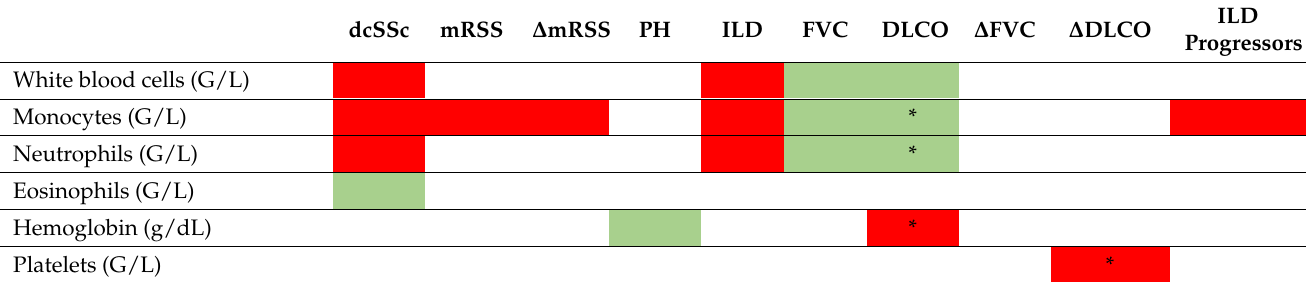
Table 4. Summary of the main results in univariate and multivariate